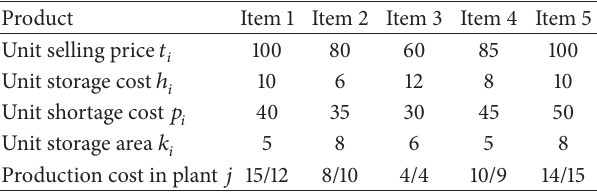
Table 2: Other parameters in the production-inventory system. Product